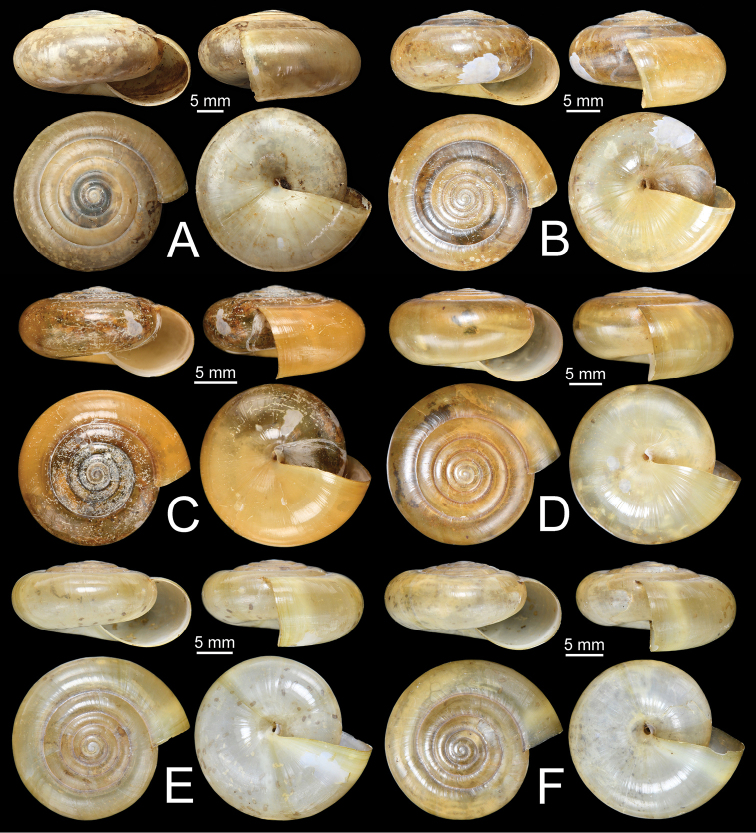
Shells of Group I: Sarika
resplendens group. A–DSarika
kawtaoensisA syntype NMW 1955.158.01170 B specimen CUMZ 7706 C specimen CUMZ 7753 and D specimen CUMZ 7236 E, FS.
caligina sp. nov. E holotype CUMZ 7259, and F paratype CUMZ 7245.